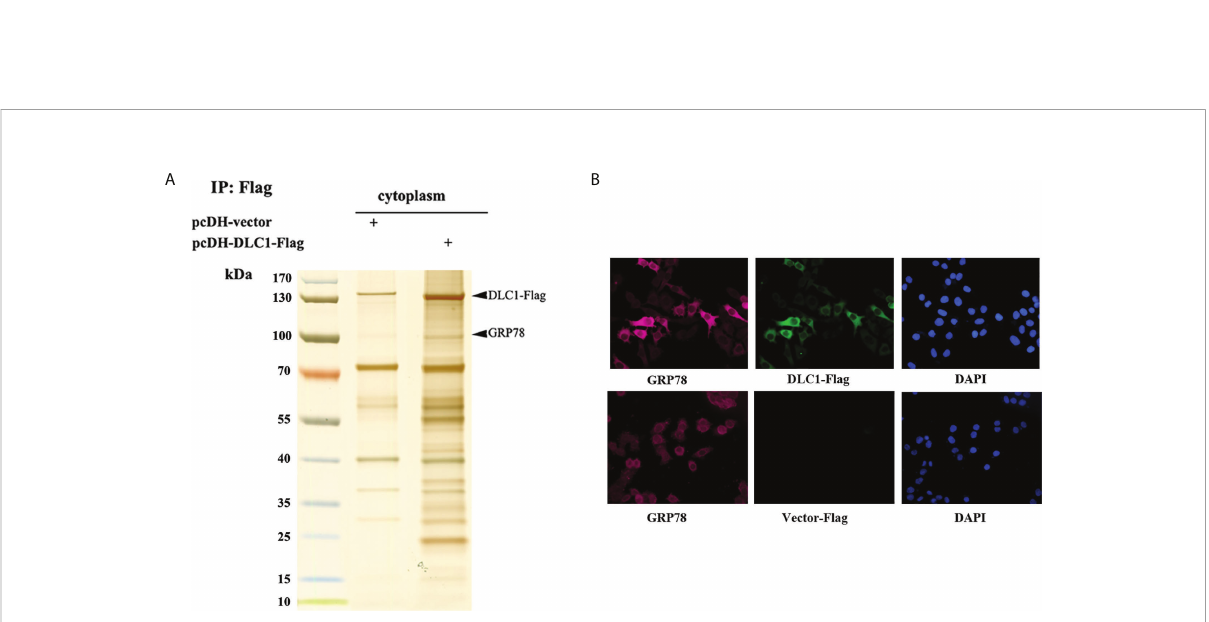
FIGURE 4 DLC1 co-localized with GRP78 in cytoplasm. (A) GRP78 was identi fi ed in cytoplasmic extracts of HEK-293T stably DLC1-Flag expressed group. (B) Immuno fl uorescence assay showed exogenous DLC1-Flag and endogenous GRP78 co-localized in cytoplasm of SW1116.